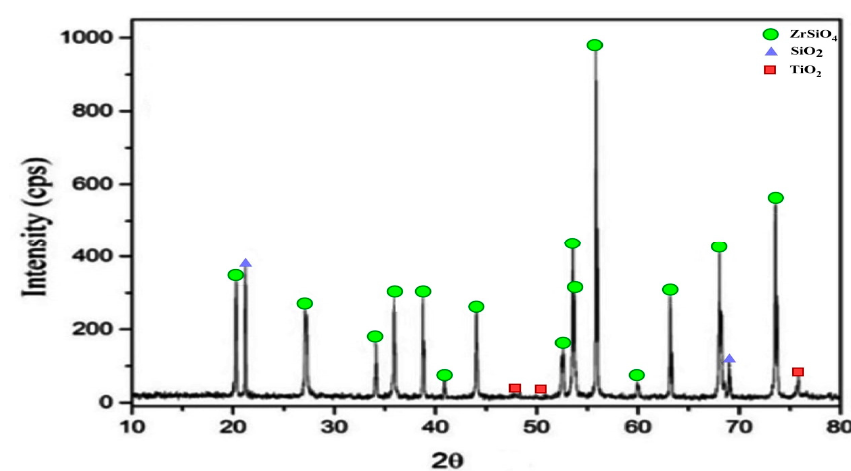
Figure 12. XRD diffractogram of the Egyptian Zircon concentrate.